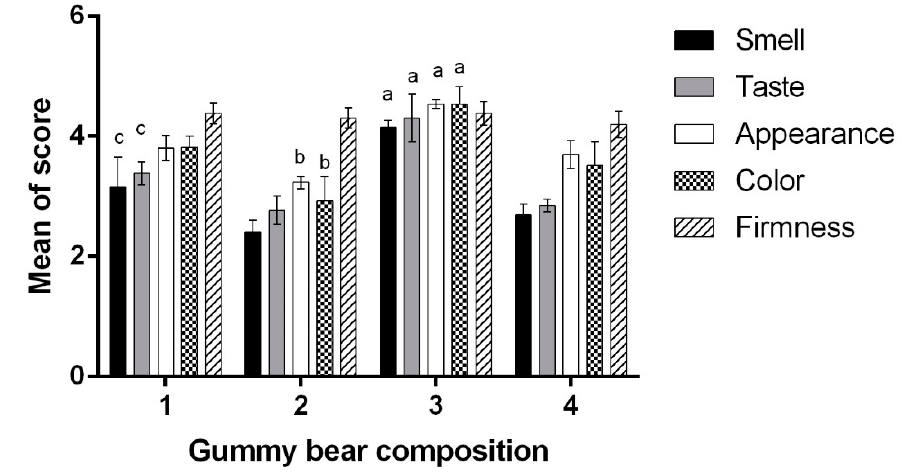
Figure 4. The influence of gummy bear composition on the textural properties. a p < 0.05 vs. 1, 2, 4 compositions; b p < 0.05 vs. 1, 4 compositions; c p < 0.05 vs. 2, 4 compositions.